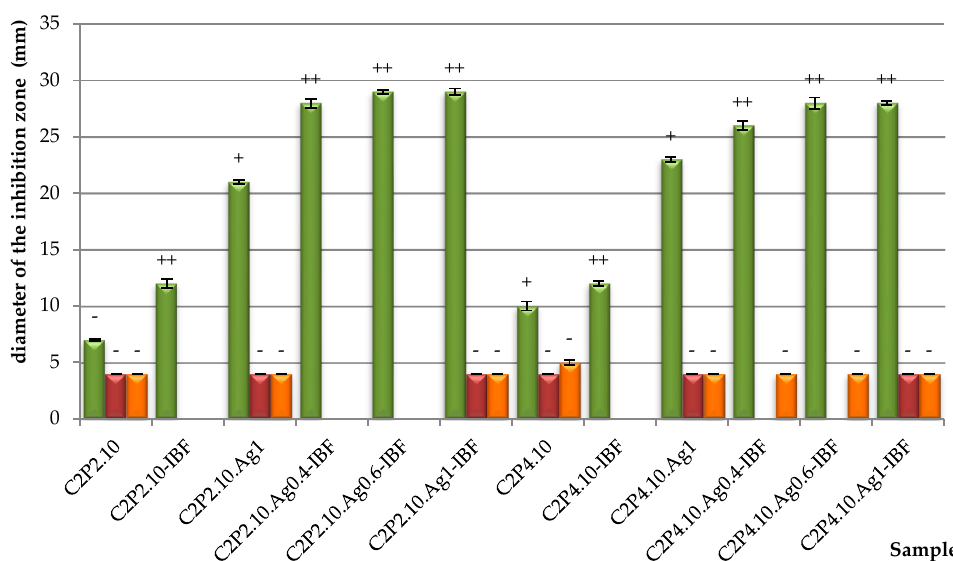
Figure 12. Diameter of inhibition zone of bacteria against S. aureus (green bars), E. coli (red bars) and